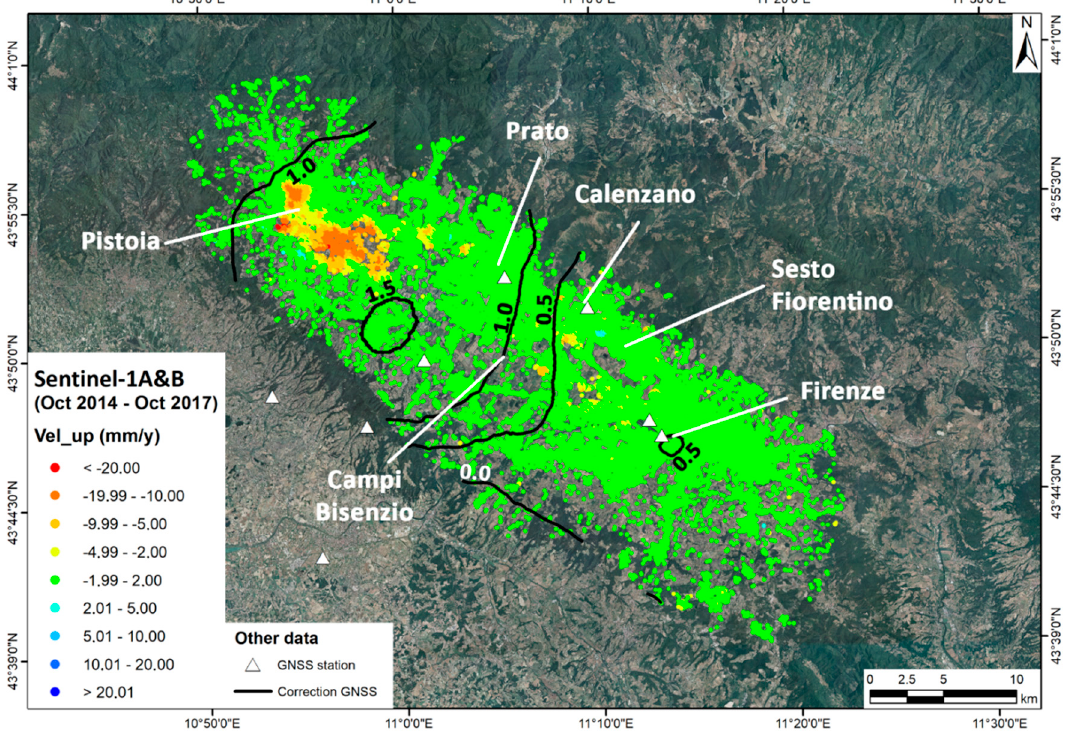
Figure 7. Corrected Sentinel-1 data (vertical velocity) and isolines of the correction values adopted for the vertical velocities.